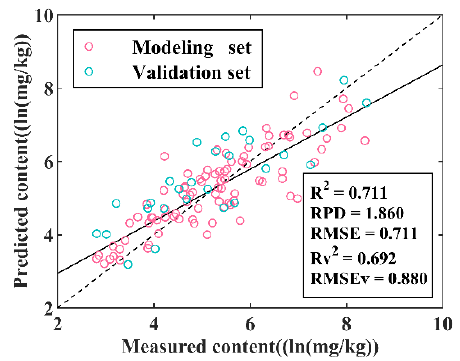
Figure 6. Scatter plot of the measured and predicted soil Pb content from optimized model.